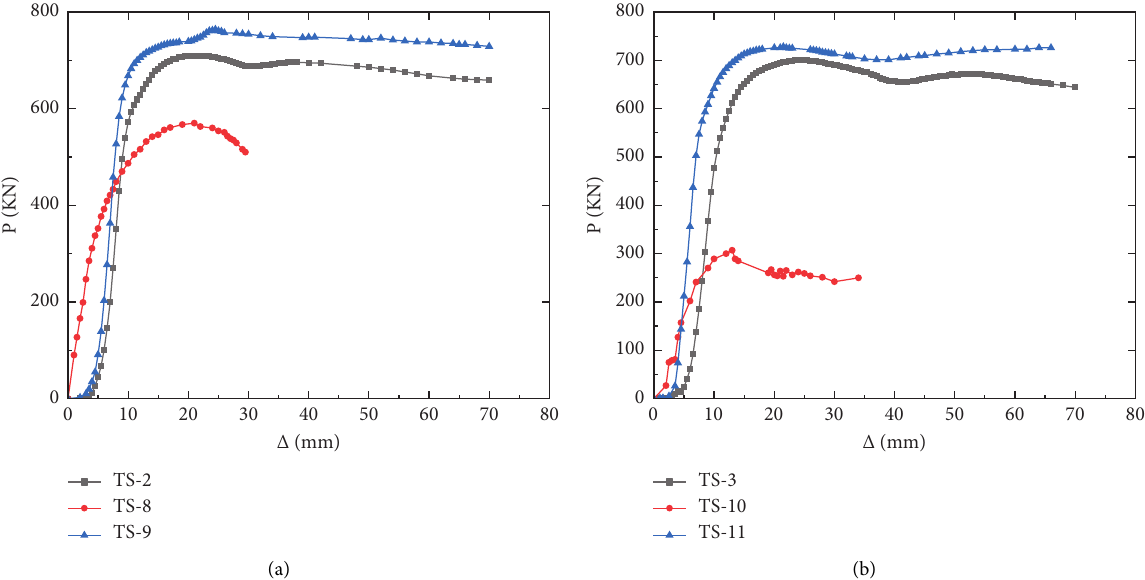
Figure 7: Load-displacement curves with different concrete